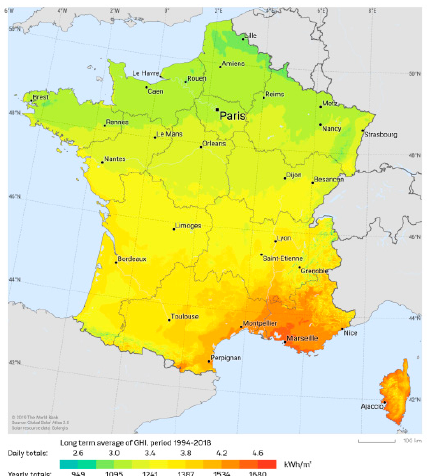
Figure 1. Global horizontal irradiation (GHI) in France. Source: [34].